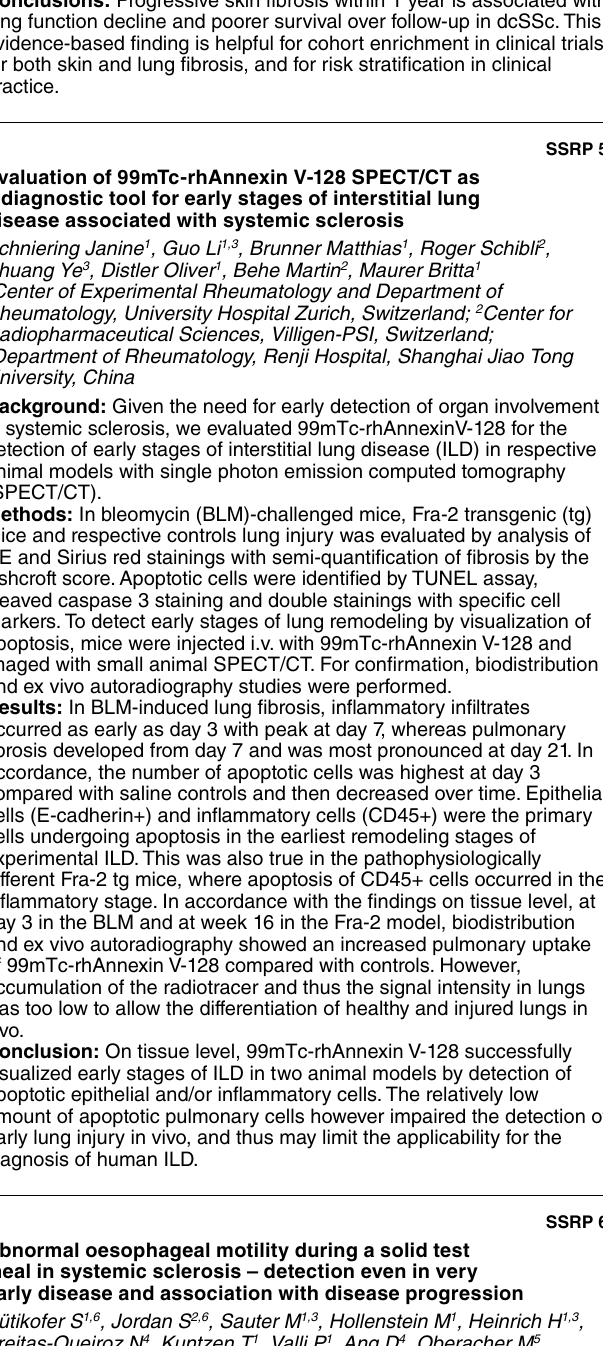
(Figure). The subanalyses with either baseline mRSS ≤22/51 or disease duration ≤15 months also revealed these findings. Multivariate all-cause death (HR 2.58, 95%CI 1.31–5.09). Conclusions: Progressive skin fibrosis within 1 year is associated